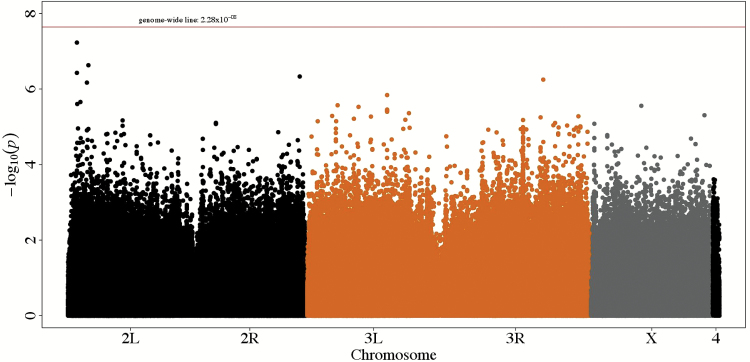
Manhattan plot for single-SNP GWAS. Each point represents a SNP. The height of the SNP represents the strength of association with lifespan, expressed as −log10(p value). The red horizontal line represents the genome-wide Bonferroni significance threshold (p = 2.28×10−08).